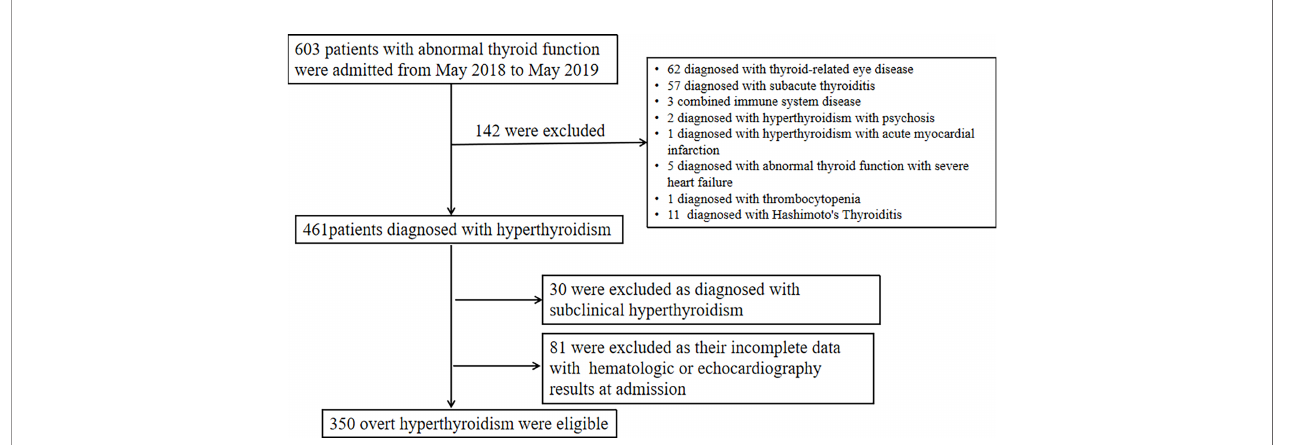
FIGURE 1 | Flow diagram showing the patient selection